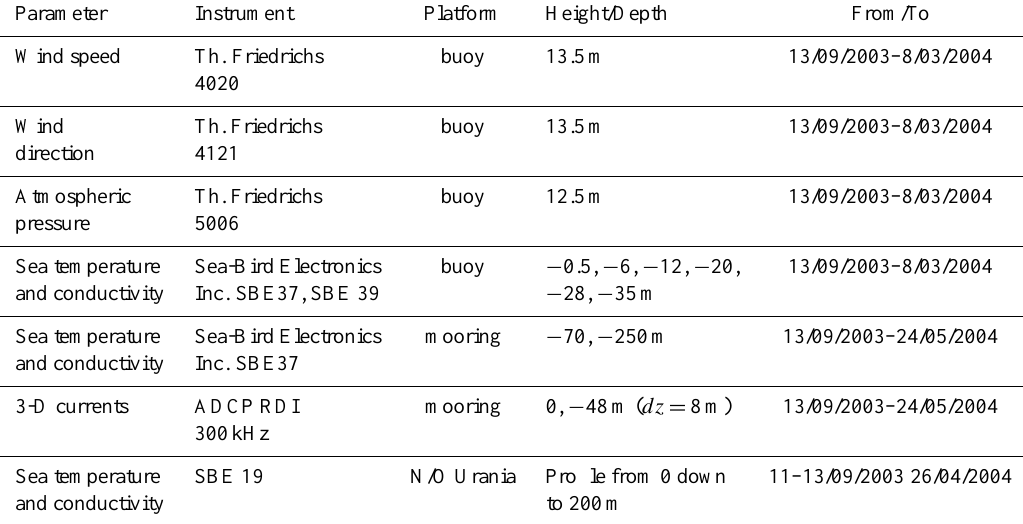
Table 1. Details of the instruments deployed on the ODAS Italia1 buoy and on the mooring and the used equipment of the N/O Urania. The table shows for each parameter: the instruments used for the measurements, the platform on which they were installed, the depth/height of the devices, and the working